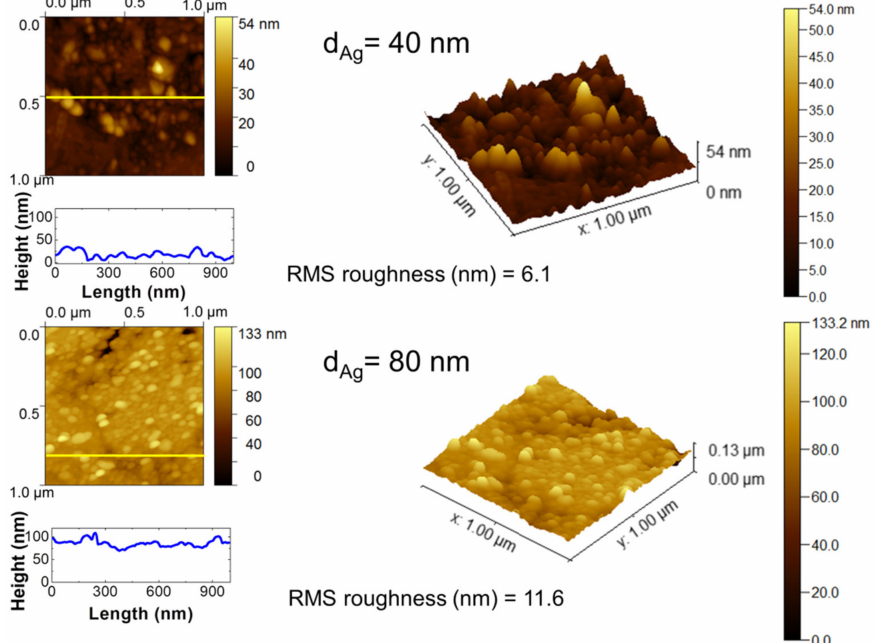
Figure 2. The 2D and 3D AFM topography scan images on 1 µ m × 1 µ m areas of vacuum-thermal- evaporated silver layers on glass substrates with nominal thicknesses of d Ag = 40 nm and d Ag = 80 nm, as indicated. The RMS roughness values are indicated. Cross-sectional surface line profiles obtained from the yellow lines of the corresponding AFM micrograph images are